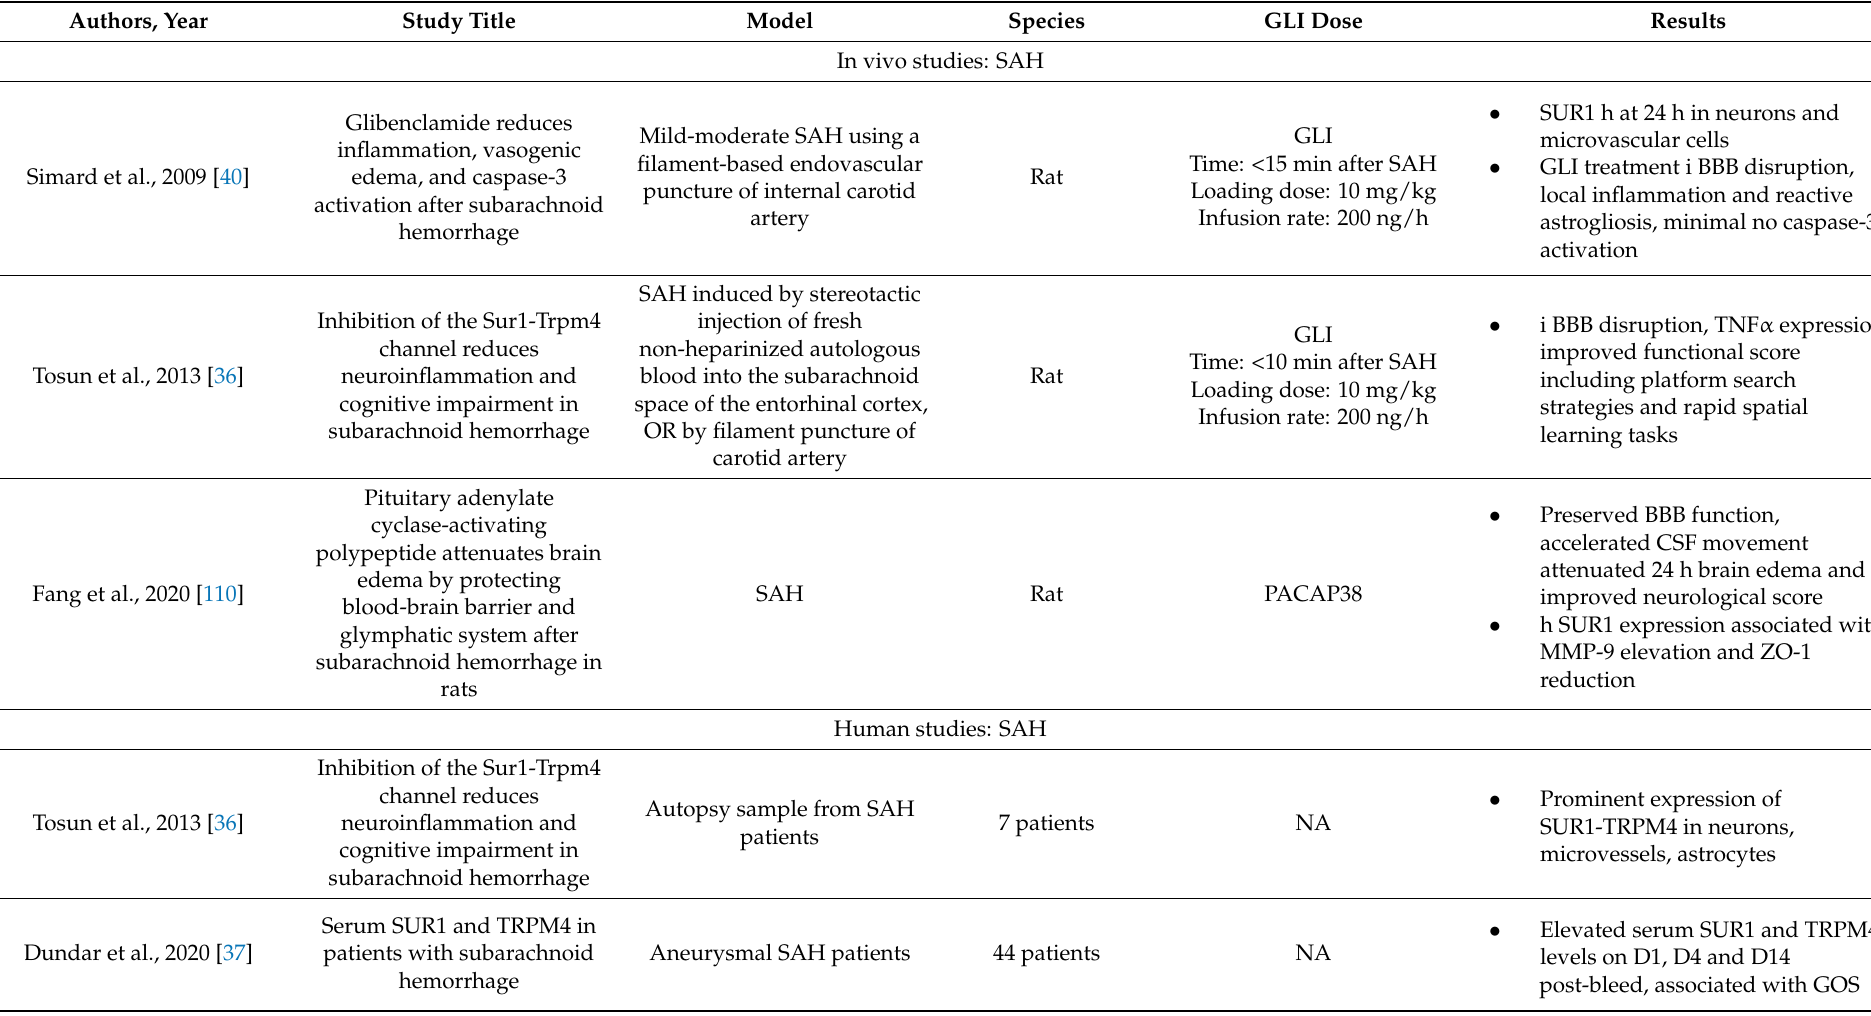
Table 6. Pre-clinical and clinical studies evaluating SUR1 inhibition for subarachnoid hemorrhage